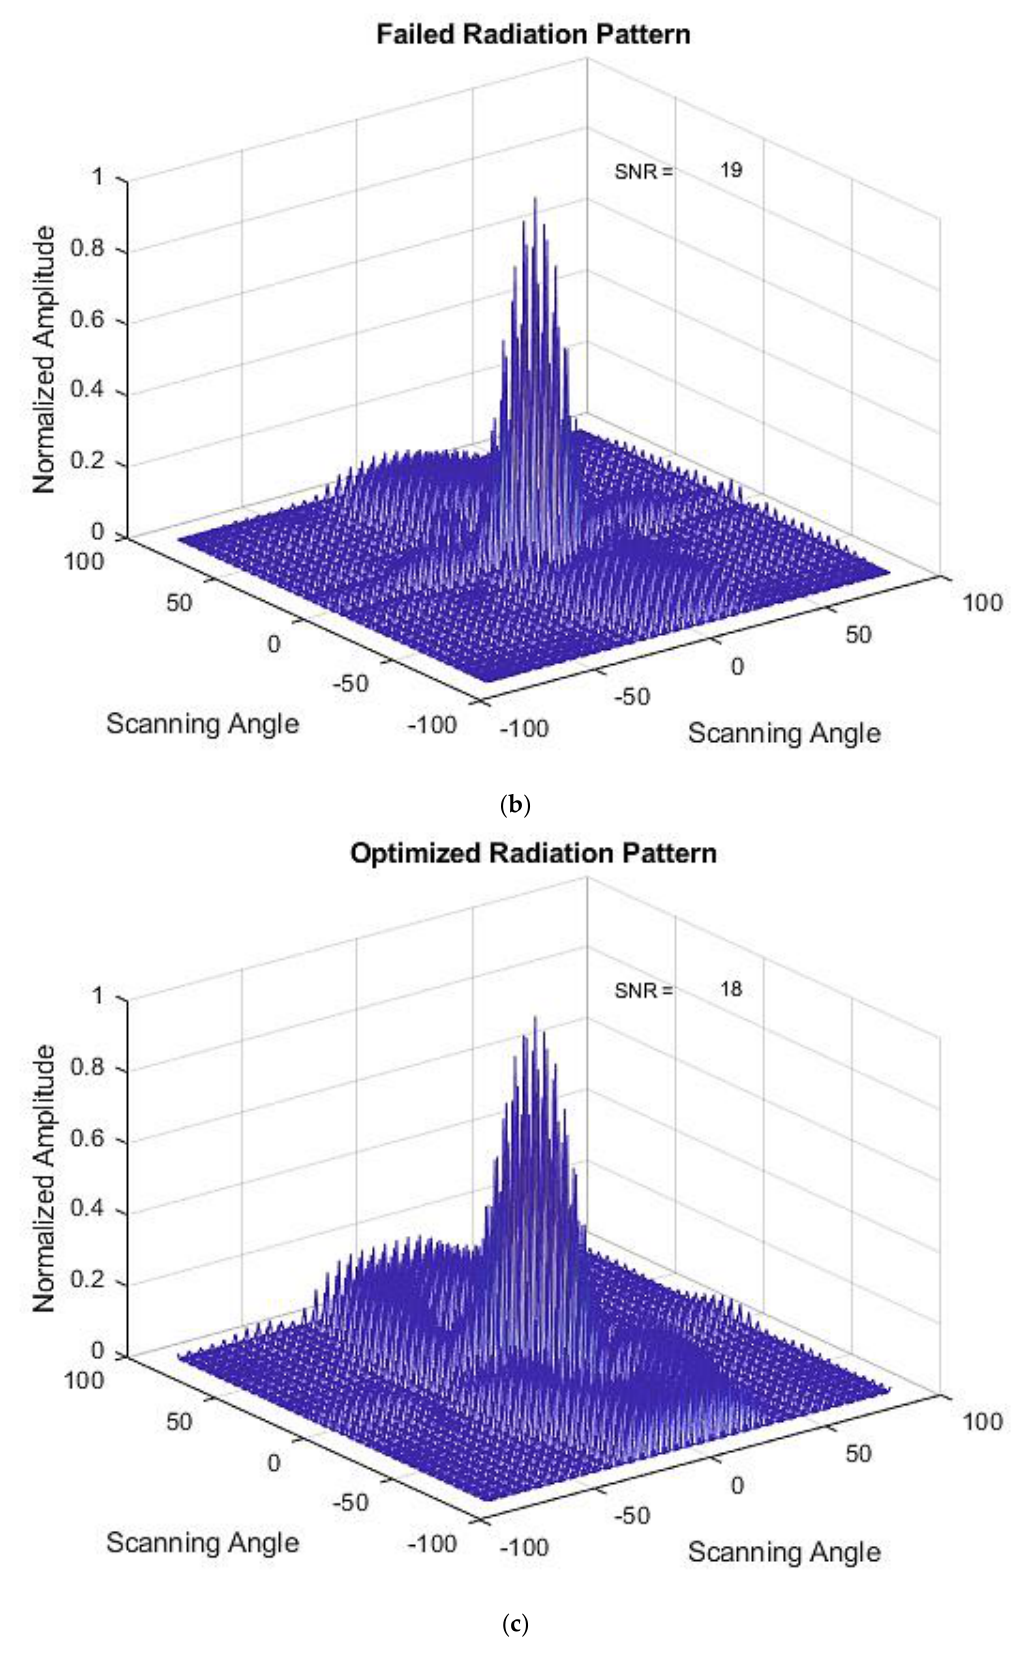
Figure 10. ( a ) Initial Radiation Pattern for the PS method. ( b ) Failed Radiation Pattern for the PS method. ( c ) Optimized Radiation Pattern for the PS method.